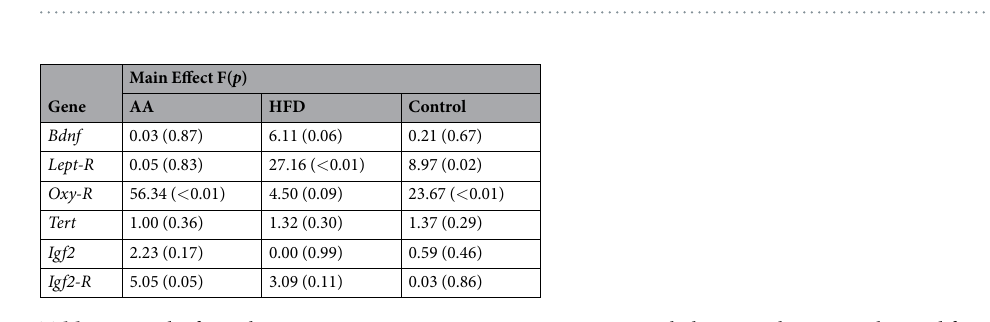
Table 1. Results from the one-way ANOVAs examining promoter methylation in sperm from fathers in the three treatment conditions.